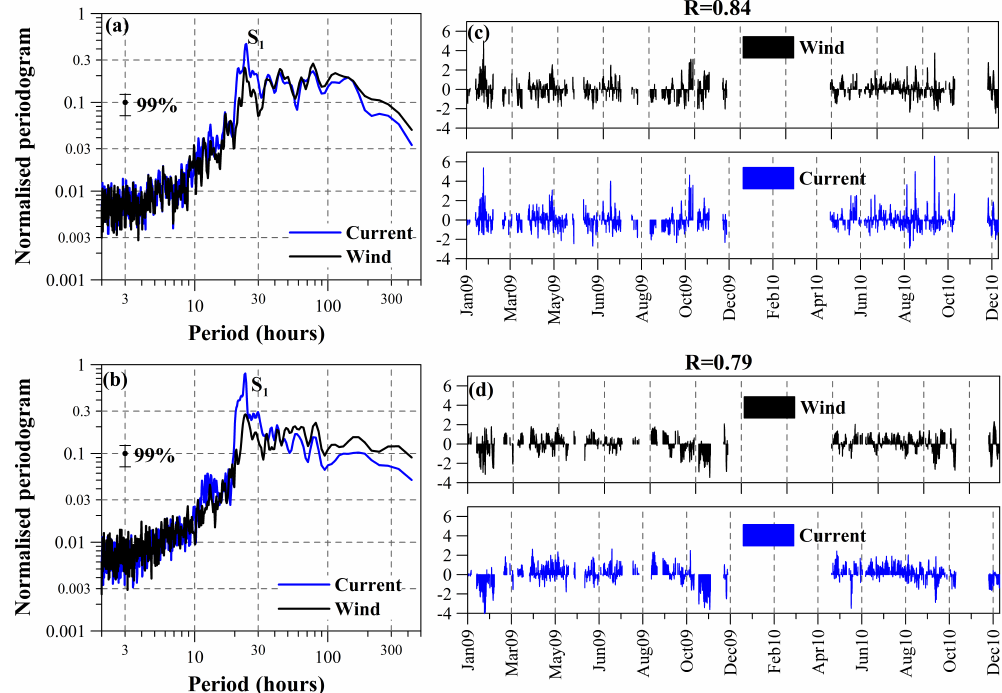
Fig. 7. Normalised Lomb–Scargle periodograms (99% confidence level) for (a) the first and (b) the second canonical variables of currents (blue) and winds (black). Normalised time series of canonical expansion coefficients for (c) the first and (d) the second canonical modes of currents (blue) and winds (black). Note: S 1 indicates the diurnal wind component (breezes) and R denotes the canonical correlation